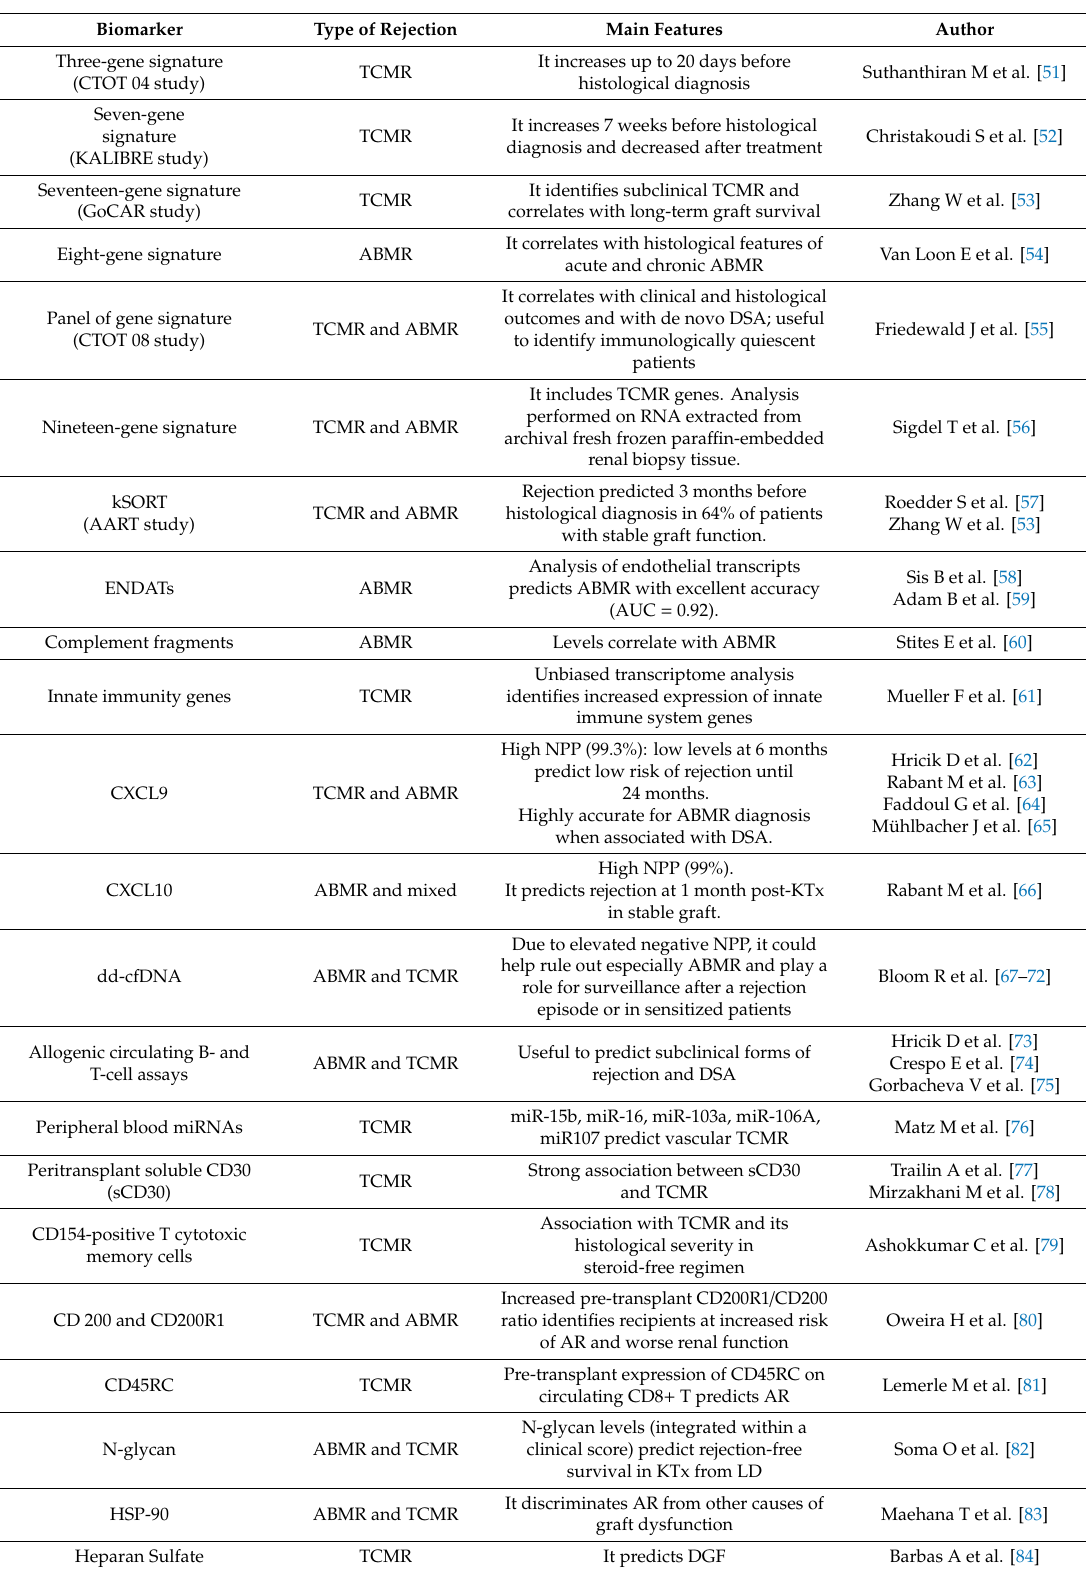
Table 4. Potential biomarkers for acute rejection